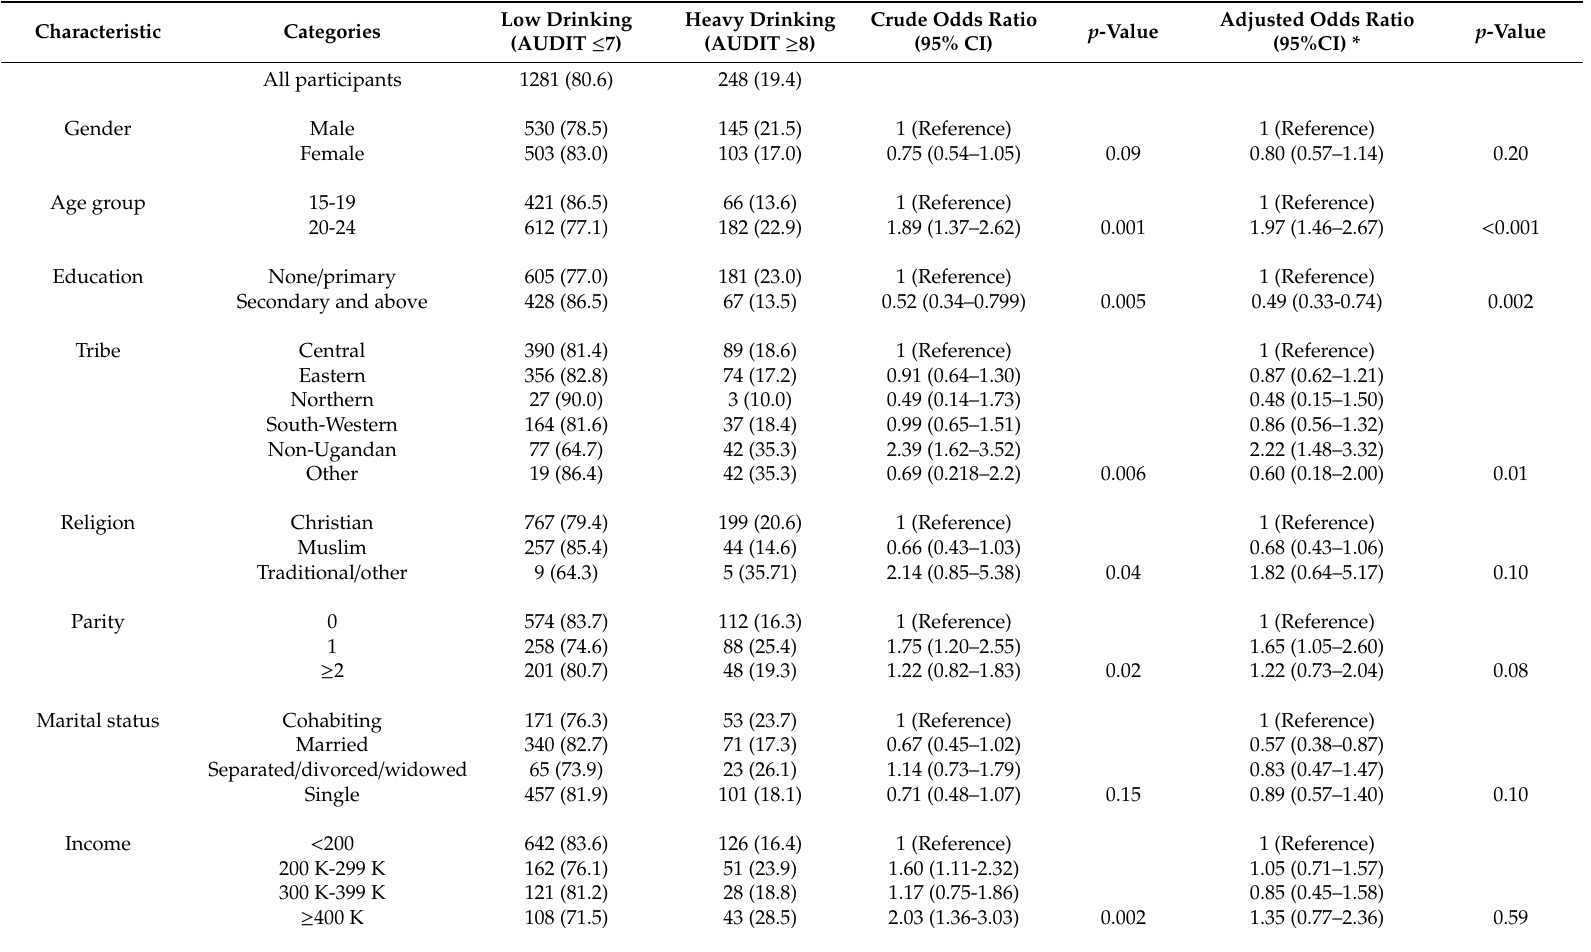
Table 2. Risk factors for alcohol misuse (AUDIT score ≥ 8) among young people aged 15–24 years in fishing communities in